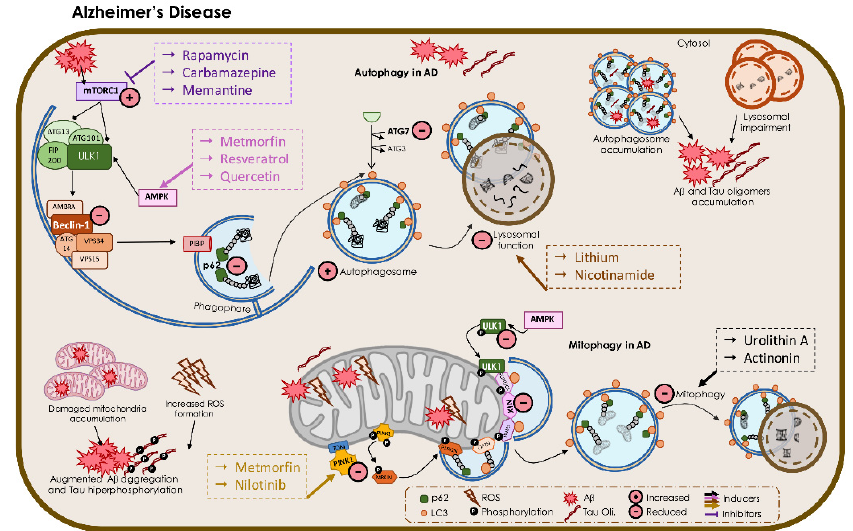
Figure 4. Overview of altered regulation of autophagy and mitophagy mechanisms in AD—role of protective compounds. Autophagy activity and related proteins are decreased in AD. mTORC1 was shown to be increased in AD, whereas its inhibitors (referred to in the purple dashed box) were shown to have positive effects in different AD models, most of them through diminished mTORC1 levels. Concordantly, AMPK inducer agents (referred to in the pink dashed box) were also shown to have positive effects in AD models. Several AD models showed increased autophagosome accumulation and reduced lysosomal function, which results in A β and Tau oligomer accumulation. Moreover, inducers of lysosomal function (referred to in the brown dashed box) were shown to significantly improve AD features in different AD models. Regarding augmented damaged mitochondria, AD models showed reduced mitophagy activity, whereas the inducer agents (referred to in the black dashed box) were also shown to increase mitophagy in AD models. Additionally, PINK1 levels were shown to be reduced in AD models, while the inducer agents (referred to in the yellow dashed box) were shown to increase those levels with positive effects.